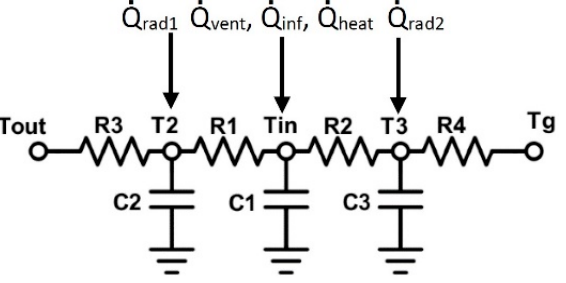
Figure 3. 4R3C model representing the building envelope and floor structures with two 2R1C branches.